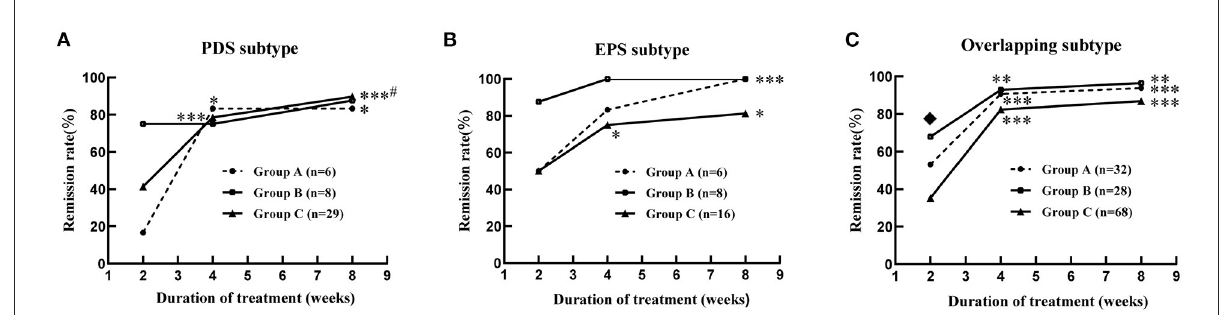
FIGURE2 Improvement of global gastrointestinal symptoms in the patients with functional dyspepsia of different subtypes combined with mood disorders at 2, 4 and 8 weeks of treatment. (A) PDS subtype; (B) EPS subtype; (C) overlapping subtype. Group A: flupentixol and melitracen + nizatidine; Group B: flupentixol and melitracen + rabeprazole; Group C: flupentixol and melitracen. PDS, postprandial distress syndrome; EPS, epigastric pain syndrome; Overlapping subtype: one or two symptoms of both PDS and EPS. * P < 0.05, ** P < 0.01, *** P < 0.001: vs. 2 weeks of treatment in the same group. # P < 0.05: vs. 4 weeks of treatment in the same group. (cid:7) P < 0.05: group B (19/28) vs. group C (24/68) at 2 weeks of treatment.